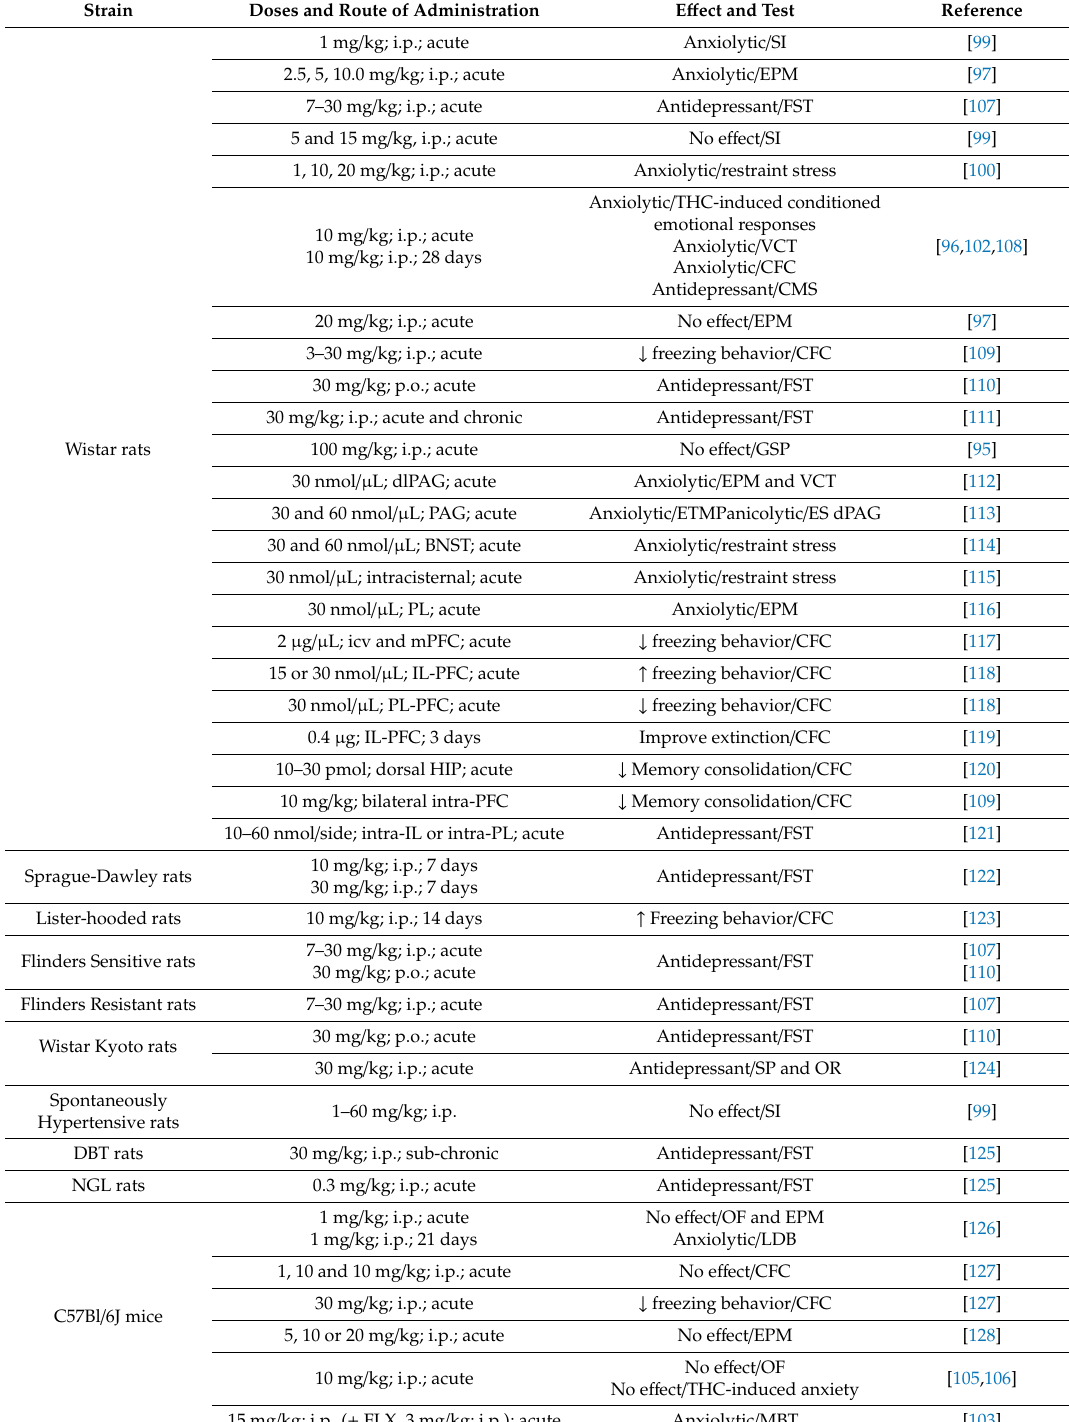
Table 2. Summary of cannabidiol studies on animal models of anxiety and